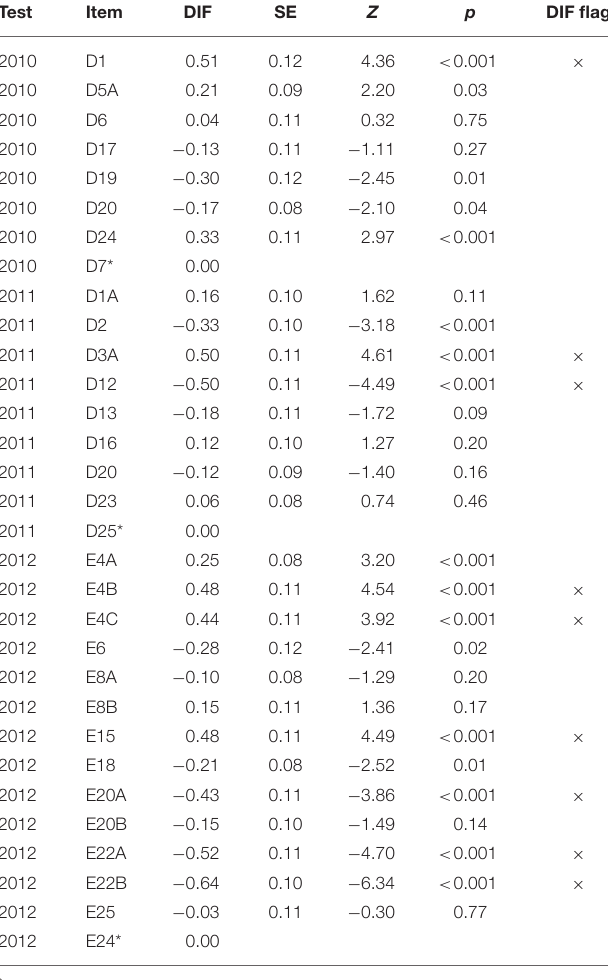
TABLE 2 | Post-test vs. INVALSI administration: DIF estimates, z statistic, and DIF diagnosis for the common items. Test